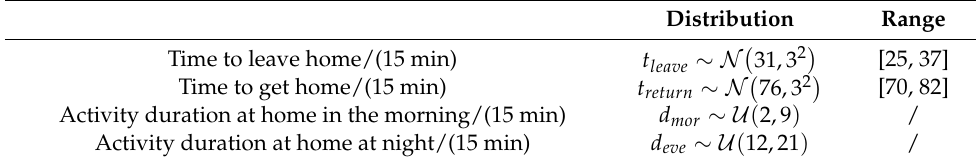
Table 3. Distribution of